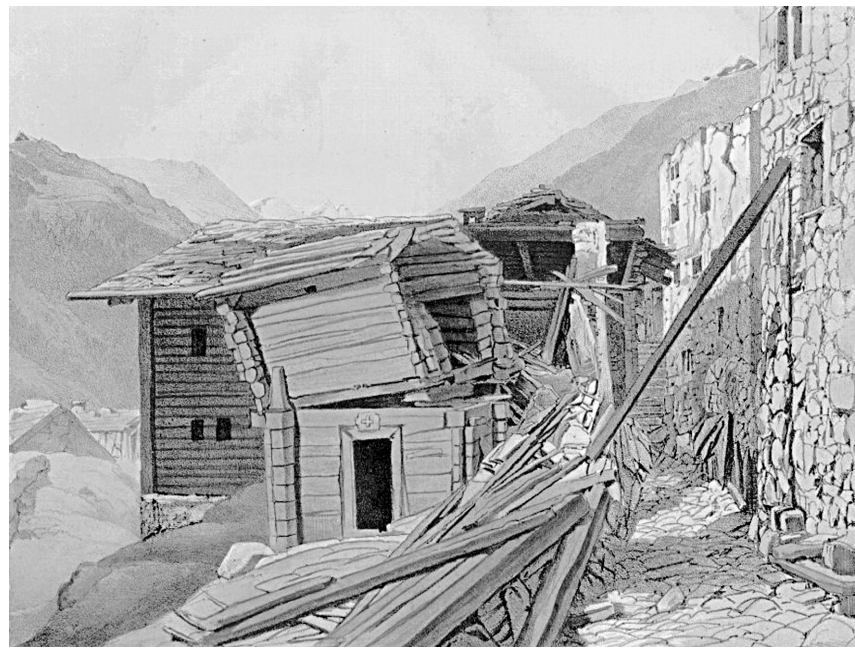
Fig. 1. Realistic drawing of an unknown artist from a typical building (Mazot) near Stalden/VS, damaged by the Earthquake of 25 July 1855 (in: Heusser,